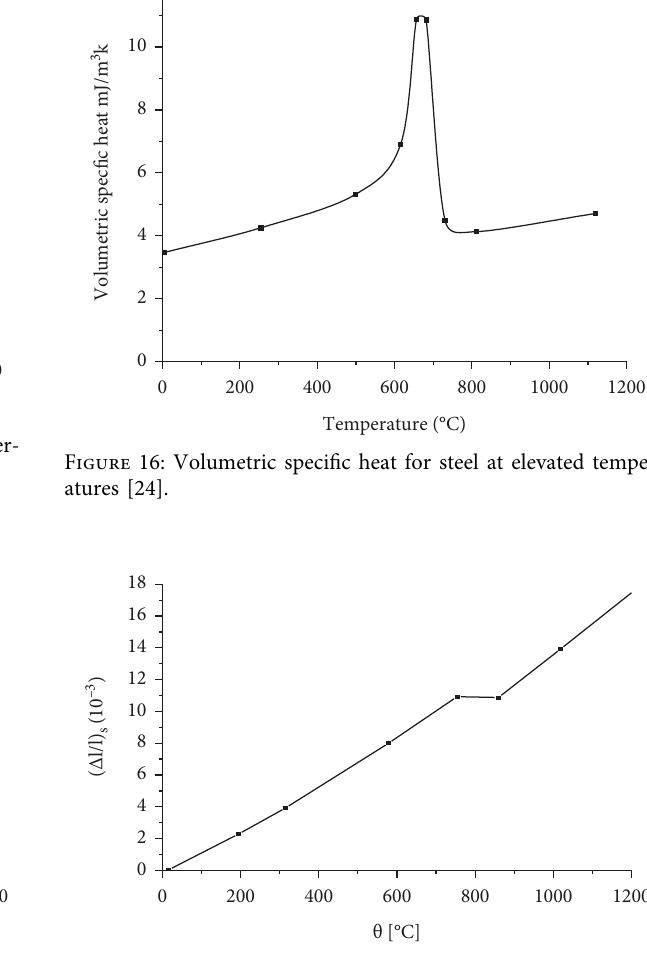
Figure 14: Concrete modulus of elasticity variation with tem- perature [19].